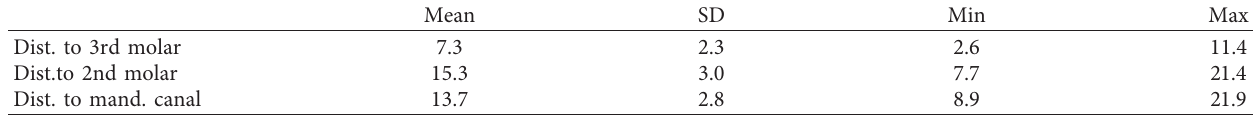
Table 3: Mean distance of retromolar canal to the mandibular canal and third and second molars.